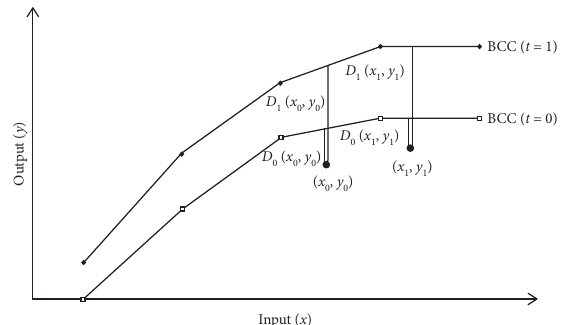
Figure 2: Representation of DEA BCC efficiency frontiers in two moments of time, as well as a DMU in two moments of time and its respective distances for each frontier (source: prepared by the